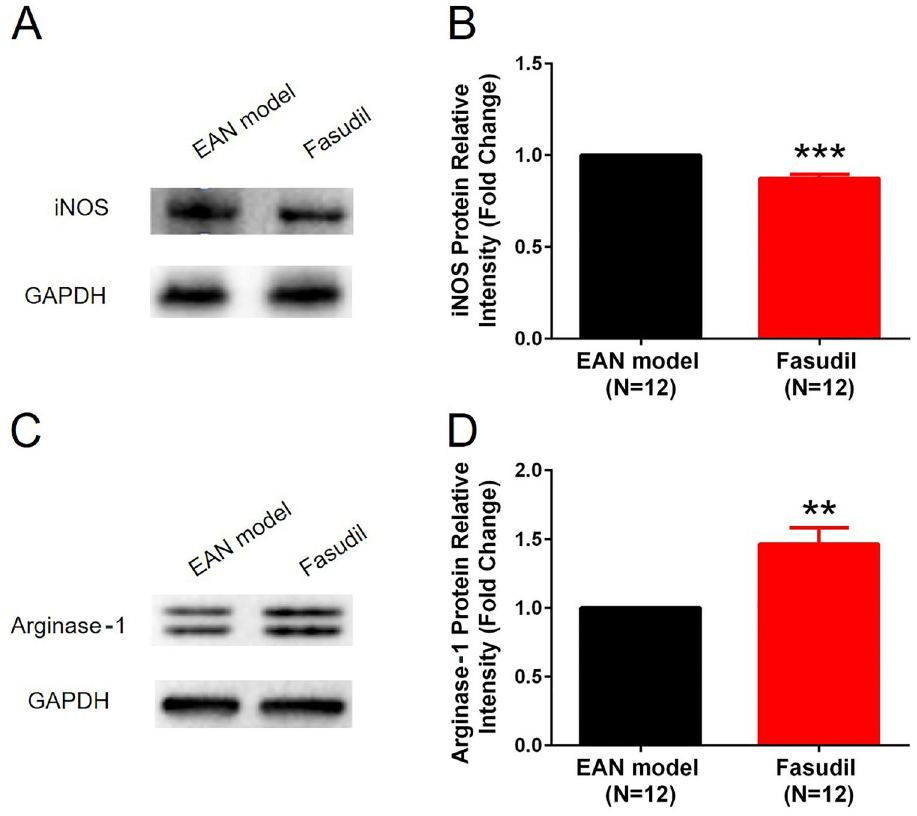
Figure 3. Inducible nitric oxide synthase (iNOS) and arginase-1 protein expressions after induction of experimental autoimmune neuritis (EAN). Fasudil reduced M1 macrophages marker iNOS protein expression ( A and B ) and enhanced M2 macrophages marker arginase- 1 expression ( C and D ) in sciatic nerves at day 28. Data are reported as mean and SD. **P o 0.01, ***P o 0.001 compared to the EAN model ( t -test).